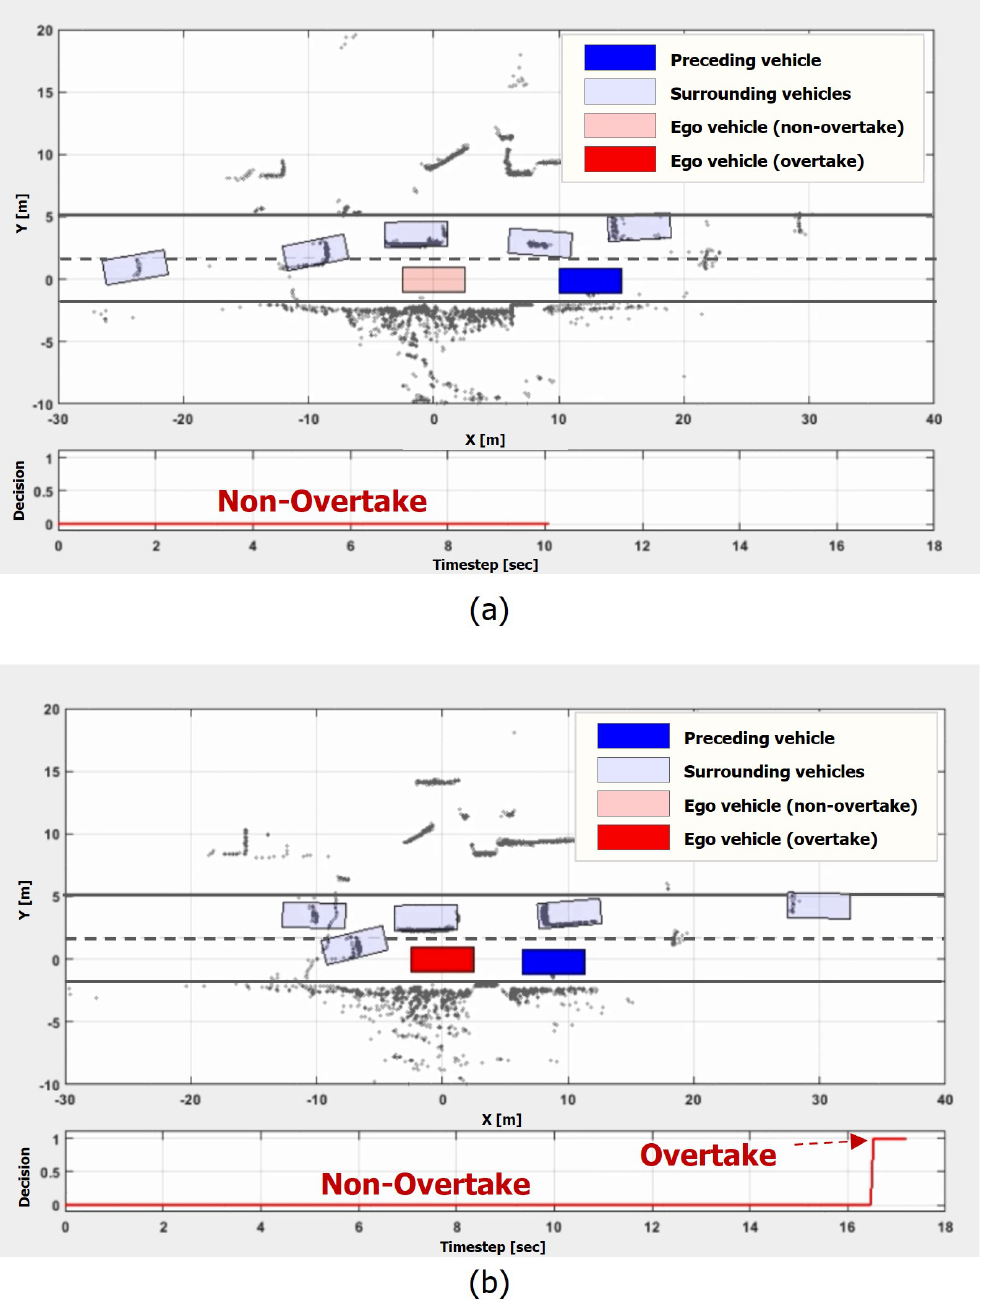
Figure 16. Heavy traffic scenario. In the scenario, the ego vehicle is behind a stationary preceding vehicle while the vehicles on the left lane are driving at around 10–20 km/h: ( a ) t = 10 s; ( b ) t = 17